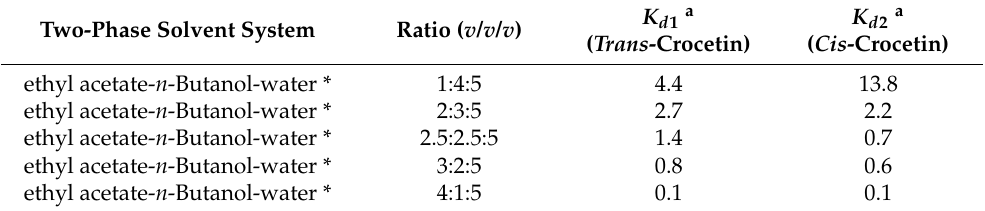
Table 4. The partition coefficient of trans ‐ and cis ‐ crocetin between the two ‐ phase solvent system. Two ‐ Phase Solvent System